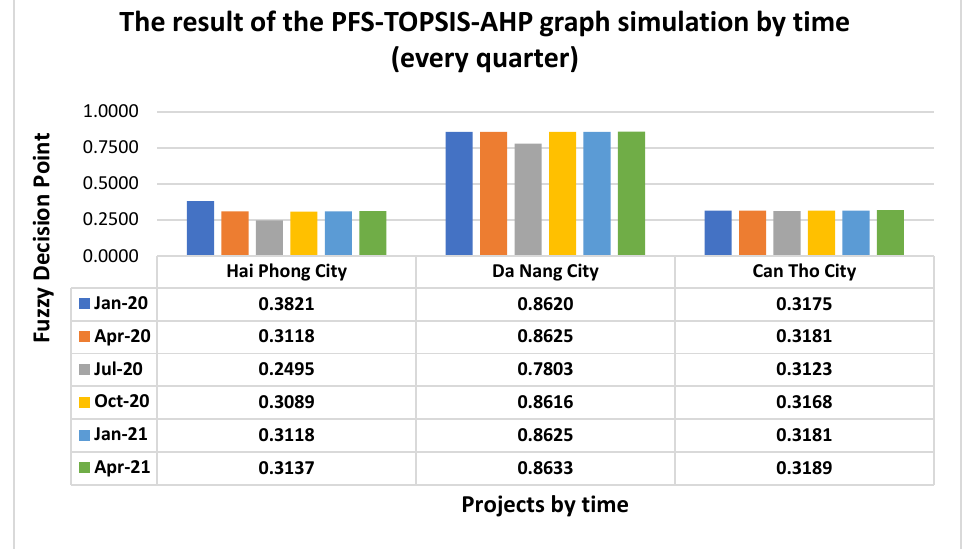
Figure 5. The evaluation result of projects by time (every